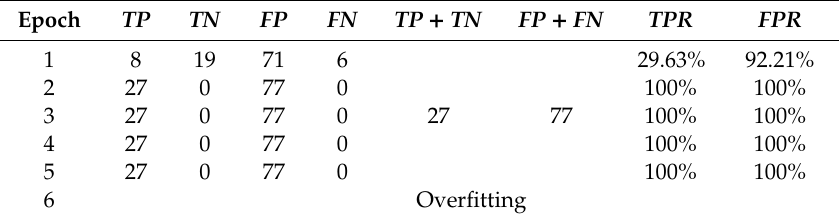
Figure 11. Training results of the CNN. Table 2. CNN assessment